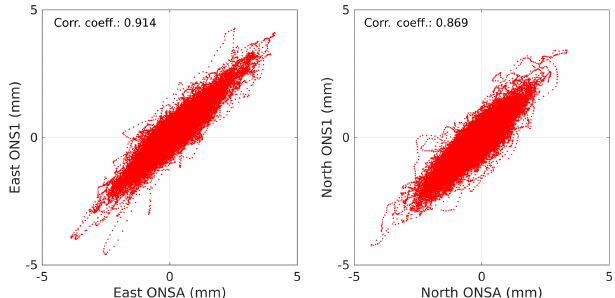
Figure 11. Correlations between estimated total gradients from the GPS stations ONSA and ONS1 using all data with a 5min resolu- tion from the period